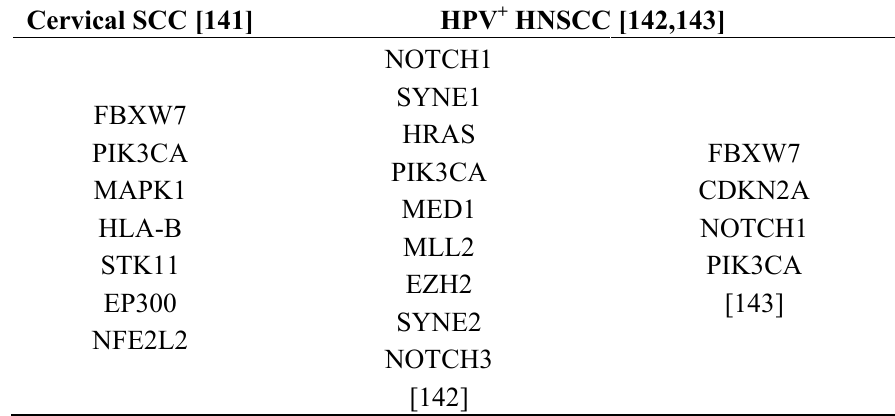
Table 3. Mutations identified by whole exome sequencing. Mutated genes that are shared between cancer